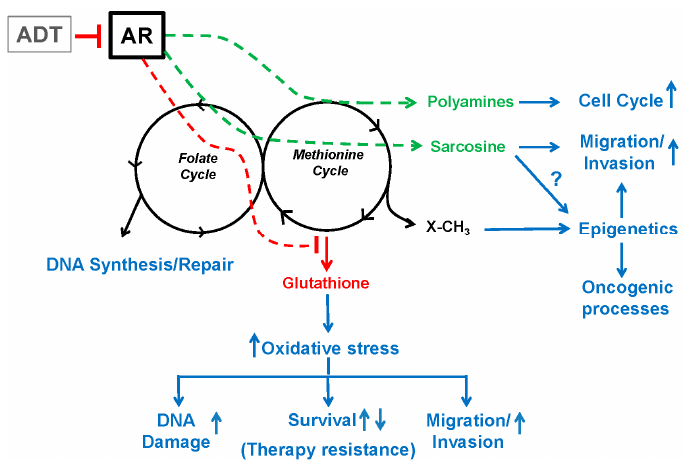
Figure 4. The AR impacts one-carbon metabolism and downstream processes by modulating the expression of specific associated enzymes. Green and red arrows/lines indicate reactions that are respectively activated and repressed by the AR via the modulation of enzyme expression. Enzymes include ODC1 (involved in polyamine synthesis), GNMT (catalyzes the conversion of glycine to sarcosine) and CBS (involved in glutathione synthesis). Metabolites increased and decreased by the AR in this manner are indicated in green and red, respectively. Black color depicts the one-carbon metabolism pathways and some other metabolites derived from it. Cellular processes potentially affected by AR-mediated one-carbon metabolism modulation are indicated in blue. By inhibiting AR, ADT (grey box) likely blocks many of these metabolic alterations in PCa cells, thus producing potentially beneficial and deleterious effects as discussed in the text.